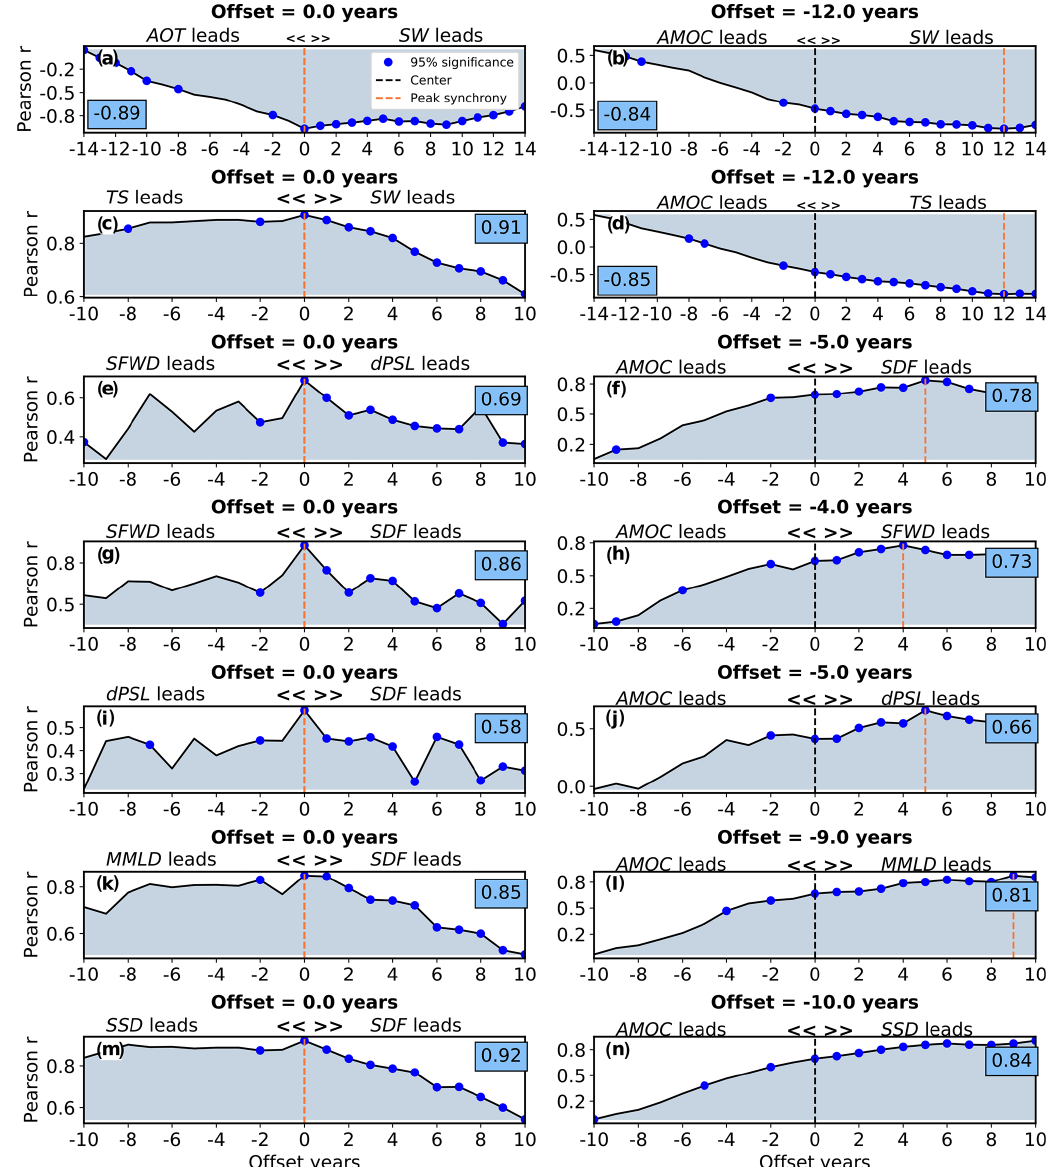
Figure 2. The 1950–2020 lead–lag AMOC correlations based on the ensemble mean annual mean all forcing Coupled Model Intercomparison Project phase 6: (a, c, e, g, i, k, m) the subpolar North Atlantic (a) aerosol optical thickness at 550nm (AOT) vs. net downward surface shortwave radiation (SW), (c) surface temperature (TS) vs. SW, (e) surface wind (SFWD) vs. sea level pressure gradient (dPSL), (g) SFWD vs. surface density flux (SDF), (i) dPSL vs. SDF, (k) March mixed-layer depth (MMLD) vs. SDF, and (m) sea surface density (SSD) vs. SDF. (b, d, f, h, j, l, n) The Atlantic meridional overturning circulation (AMOC) vs. the subpolar North Atlantic (b) SW, (d) TS, (f) SDF, (h) SFWD, (j) dPSL, (l) MMLD, and (n) SSD. The maximum correlation is denoted by the text in the blue box. Blue-filled circles denote correlations that are significant at the 95% confidence level. The corresponding offset in years is denoted by the vertical dashed red